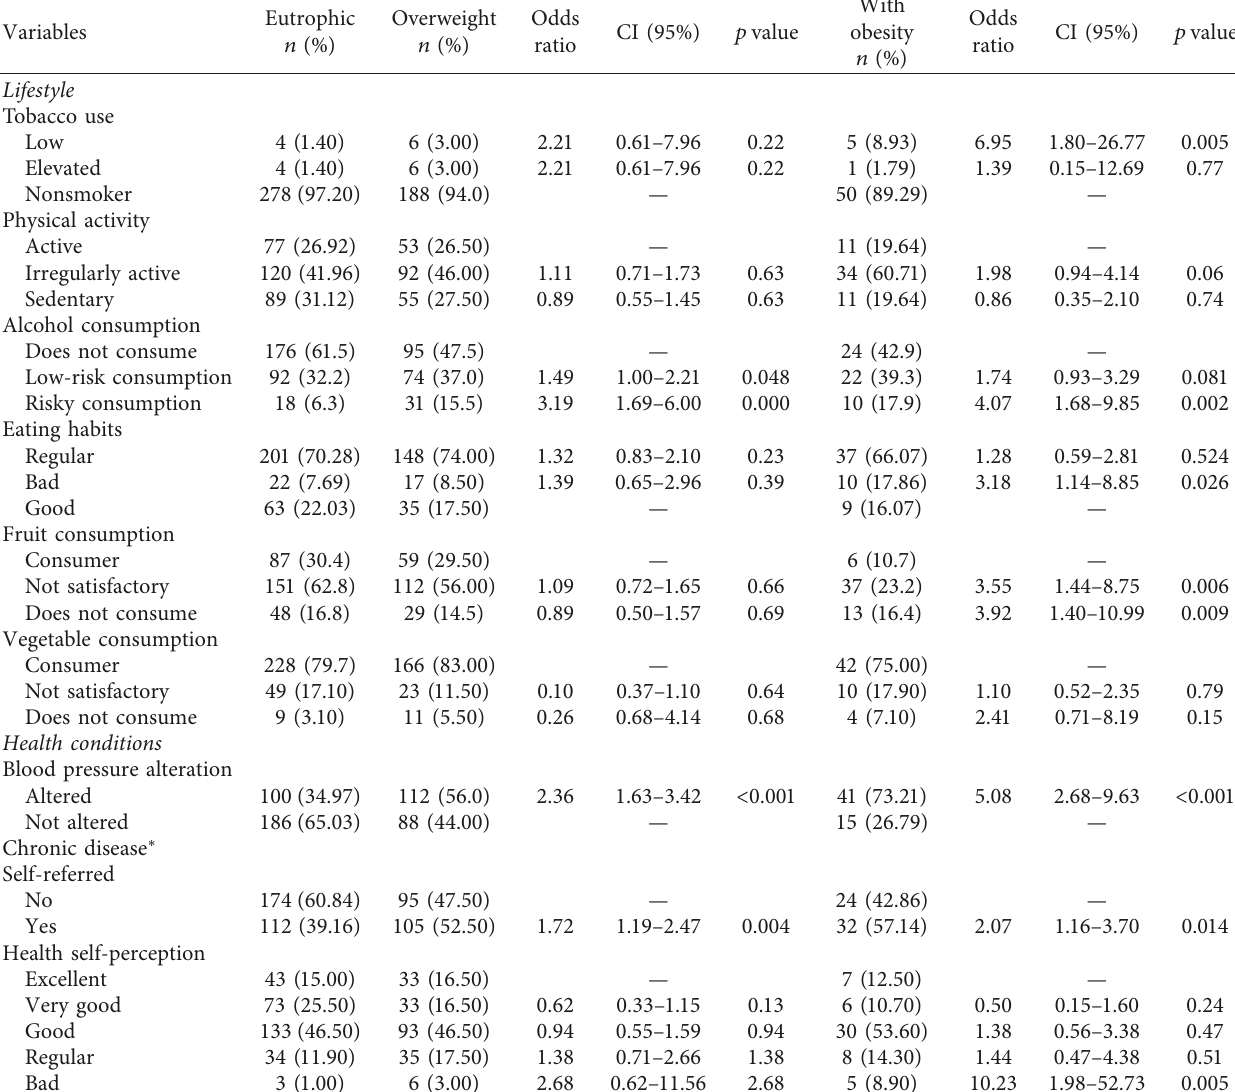
Table 2: Risk of overweight and obesity related to eutrophy and lifestyle and health conditions of Japanese-Brazilians in the city of Maring´a-PR, Brazil,